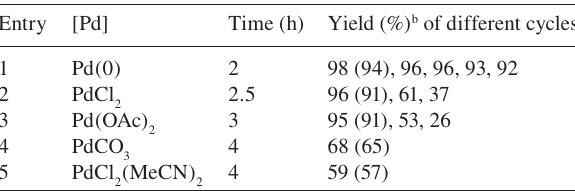
Table 1 Sonogashira reaction of iodobenzene and phenylacetylene in water. a